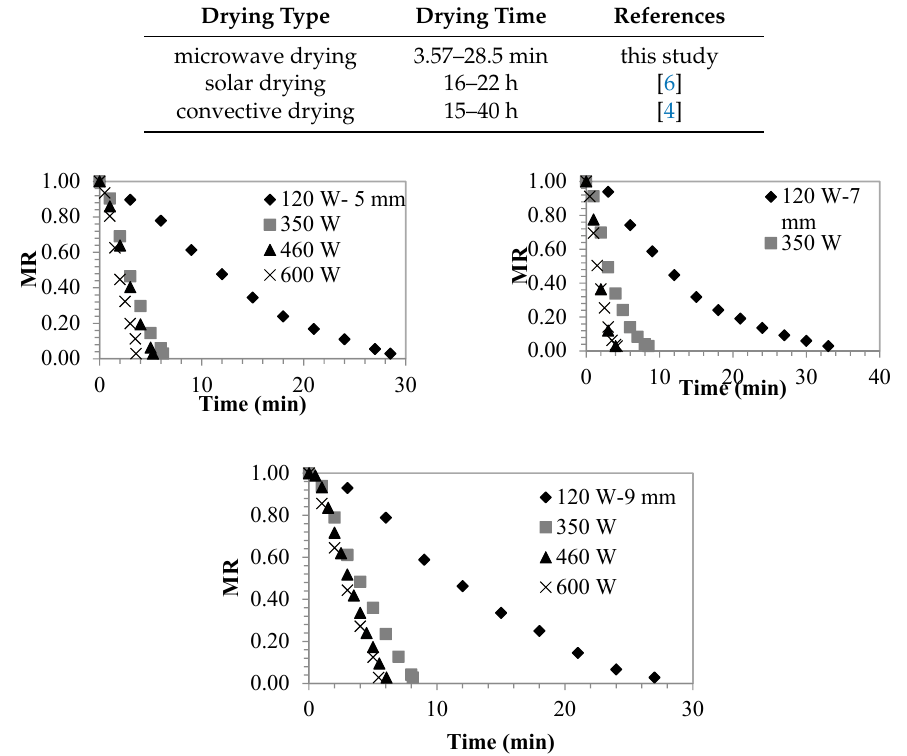
Figure 2. Changes in the moisture content based on time of the persimmons dried in varying microwave powers and varying slice thicknesses.